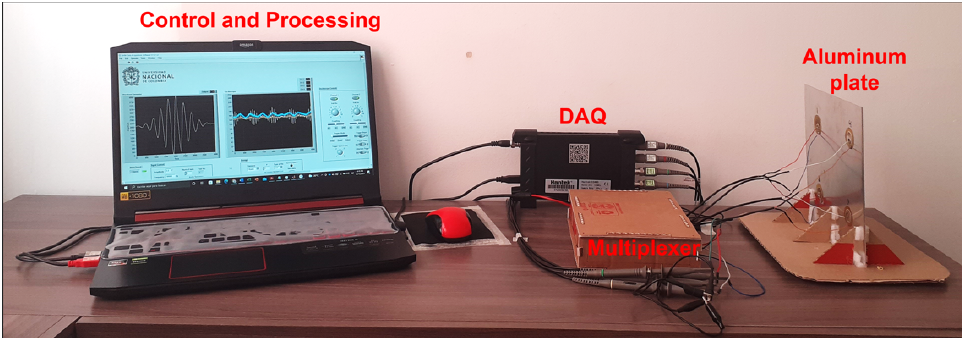
Figure 13. Experimental setup.